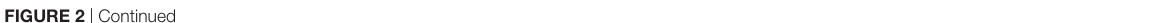
cells undergo apoptosis after challenge with rSFV particles ( Figure 4D , red and white arrows), whereas part of infected DsRed-expressing cells remain viable 48 h post-infection ( Figure 4D , yellow arrows). Flow cytometry analysis revealed that 69% of all DsRed-expressing cells undergo cell death char- acterized mostly by being double-positive for Annexin V-FITC and DAPI ( Figure 4E ). Our data show that macrophages are not only resistant to SFV infection but also remain viable after challenge with rSFV